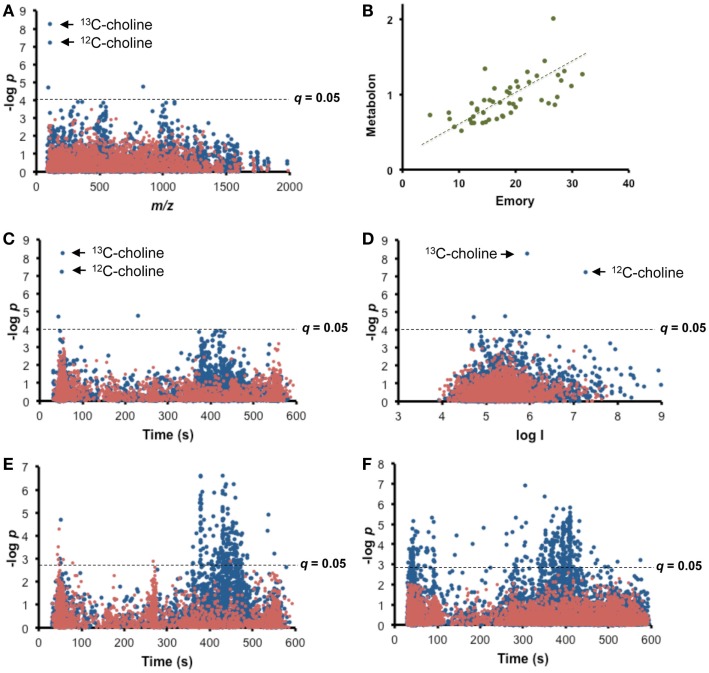
Targeted MWAS for choline. (A) Type 1 Manhattan plot for Pearson correlation of targeted choline measurements (Metabolon) with each m/z feature in high-resolution metabolomics (HRM) for 50 plasma samples from common marmosets. (B) Comparison of Metabolon values with corresponding HRM analysis at Clinical Biomarkers Laboratory. Values are expressed as relative units. (C) Type 2 Manhattan plot of targeted choline measurements as a function of retention time of m/z feature suggests association of choline with lipids. (D) Type 3 Manhattan plot of targeted choline measurements as a function of ion intensity shows that correlated 12C and 13C forms of choline have expected differences in ion intensity and that other significantly associated and unidentified m/z features are present with lower ion intensities. (E) Internal Targeted MWAS is shown as type 2 Manhattan plot for Pearson correlation of choline within the HRM analysis. Results show significant associations of choline with m/z features eluting after 350 s. (F) Targeted MWAS for choline in human plasma. Type 2 Manhattan plot for Pearson correlation of choline within the HRM analysis of plasma of 50 healthy humans shows significant associations of choline m/z features eluting after 350 s. Mean choline concentration was 5.8 ± 0.8 μM. In (E) and (F), self-correlations of different forms of choline were removed to facilitate visualizations of correlation of choline with other m/z features. Positive correlations are shown in blue and negative correlations in red. FDR corrected significance level is shown as broken line.